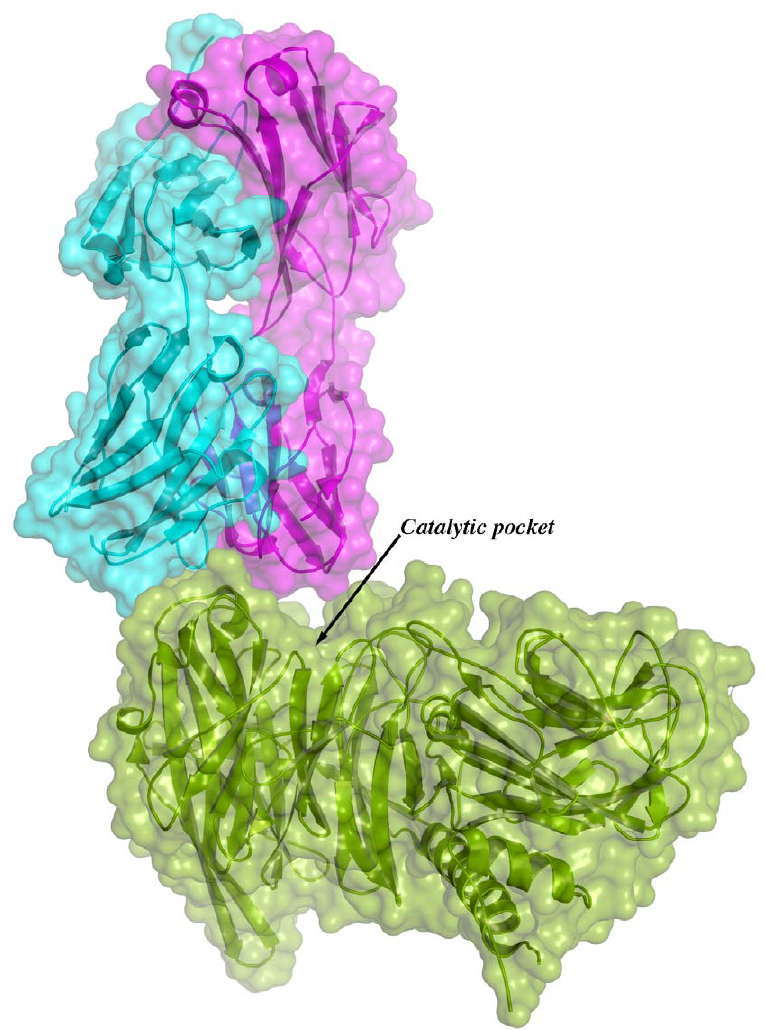
Figure 3. Overall structure of one binary immunocomplex. Immunocomplex 1 (IC1 as defined in the text) is depicted as a background cartoon representation with a superposed transparent solvent-accessible surface rendered in colors. trans -Sialidase is colored green, Fab light chain magenta and heavy chain cyan. The antibody light chain is slightly occluding the entrance of the enzyme’s catalytic pocket, while the heavy chain is more eccentric, establishing a large interaction surface on one side of the reaction